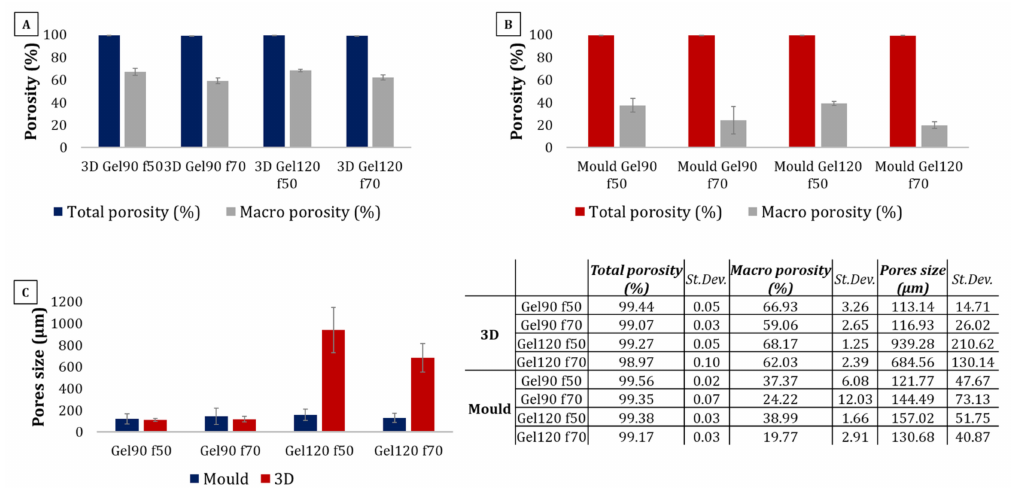
Figure 4. Total and macro porosities of 3D-printed ( A ) and mould-casted ( B ) scaffolds, and their corresponding pore sizes ( C